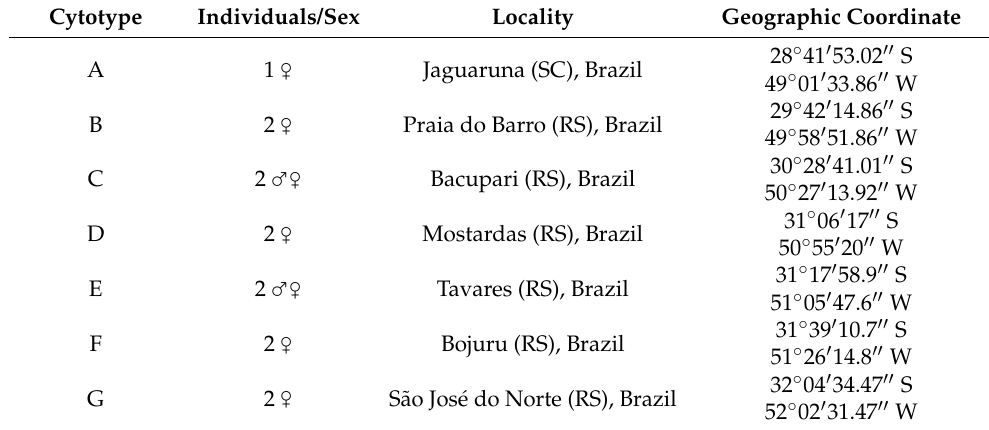
Table 2. Collection sites for the analyzed C. minutus cytotypes, together with the respective sample sizes. Cytotype Individuals/Sex